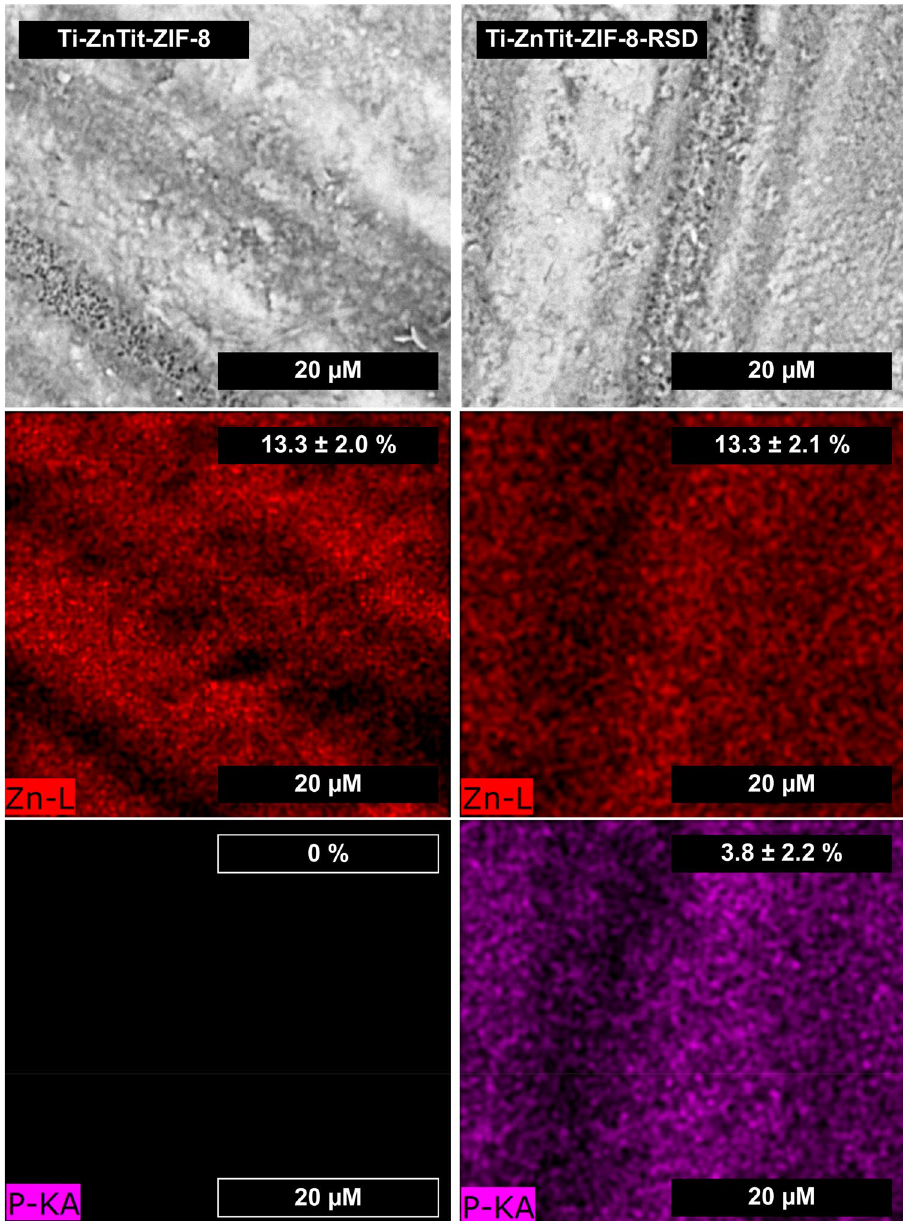
Figure 4. SEM images of alloys (first row). Elemental mapping of the same regions indicating the spatial distribution of zinc (second row) and phosphorus (third row). The values represent the content of elements on the alloy surface (by